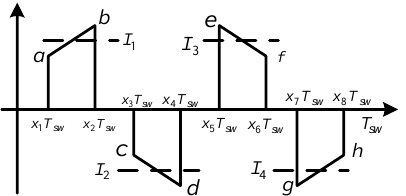
Figure 12. Generalized composite waveform .